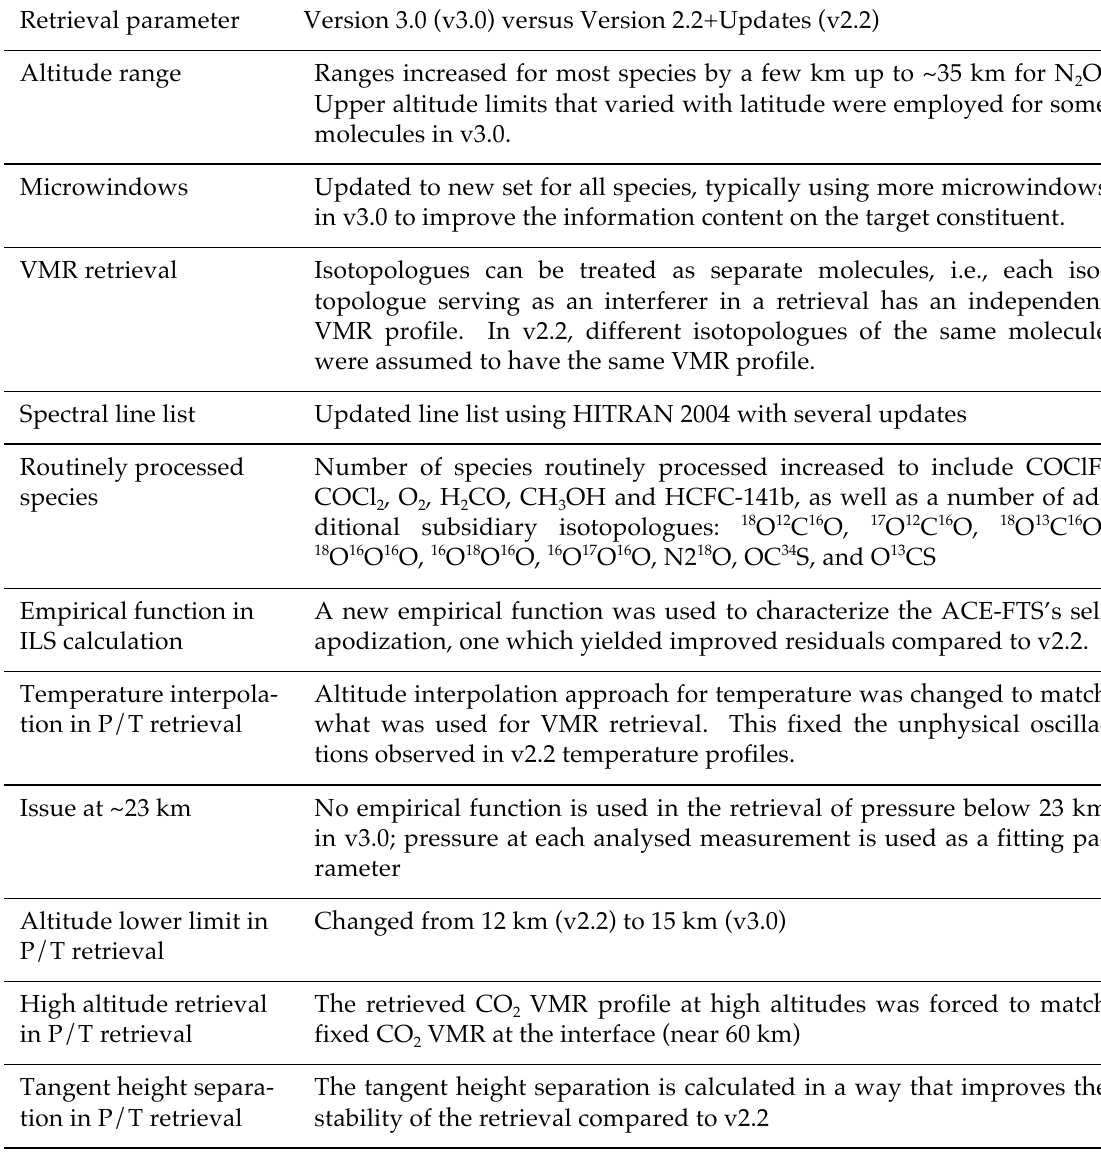
Table 1 : Summary of the processing differences between ACE-FTS v2.2 and v3.0. Retrieval